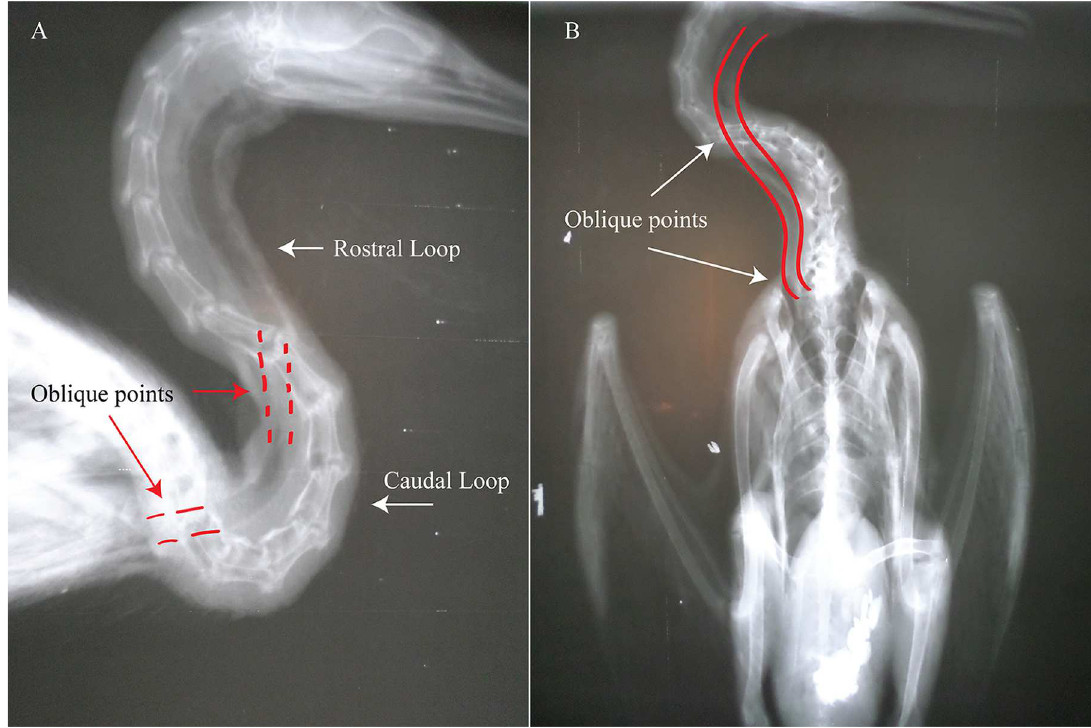
Fig 16. Radiographs of P . auritus neck. (A) “Rostralloop”is the upperhalf of the “S” shape of the bird neck; while the “caudal loop”is the lower half. Terminology afterVan der Leeuwet al. [63].Lateralview showing the course of the tracheaand its oblique points (pointwherethe tracheacrosses planes(medialto lateraland vice versa). (B) ventral view showing the course of the tracheaand its oblique